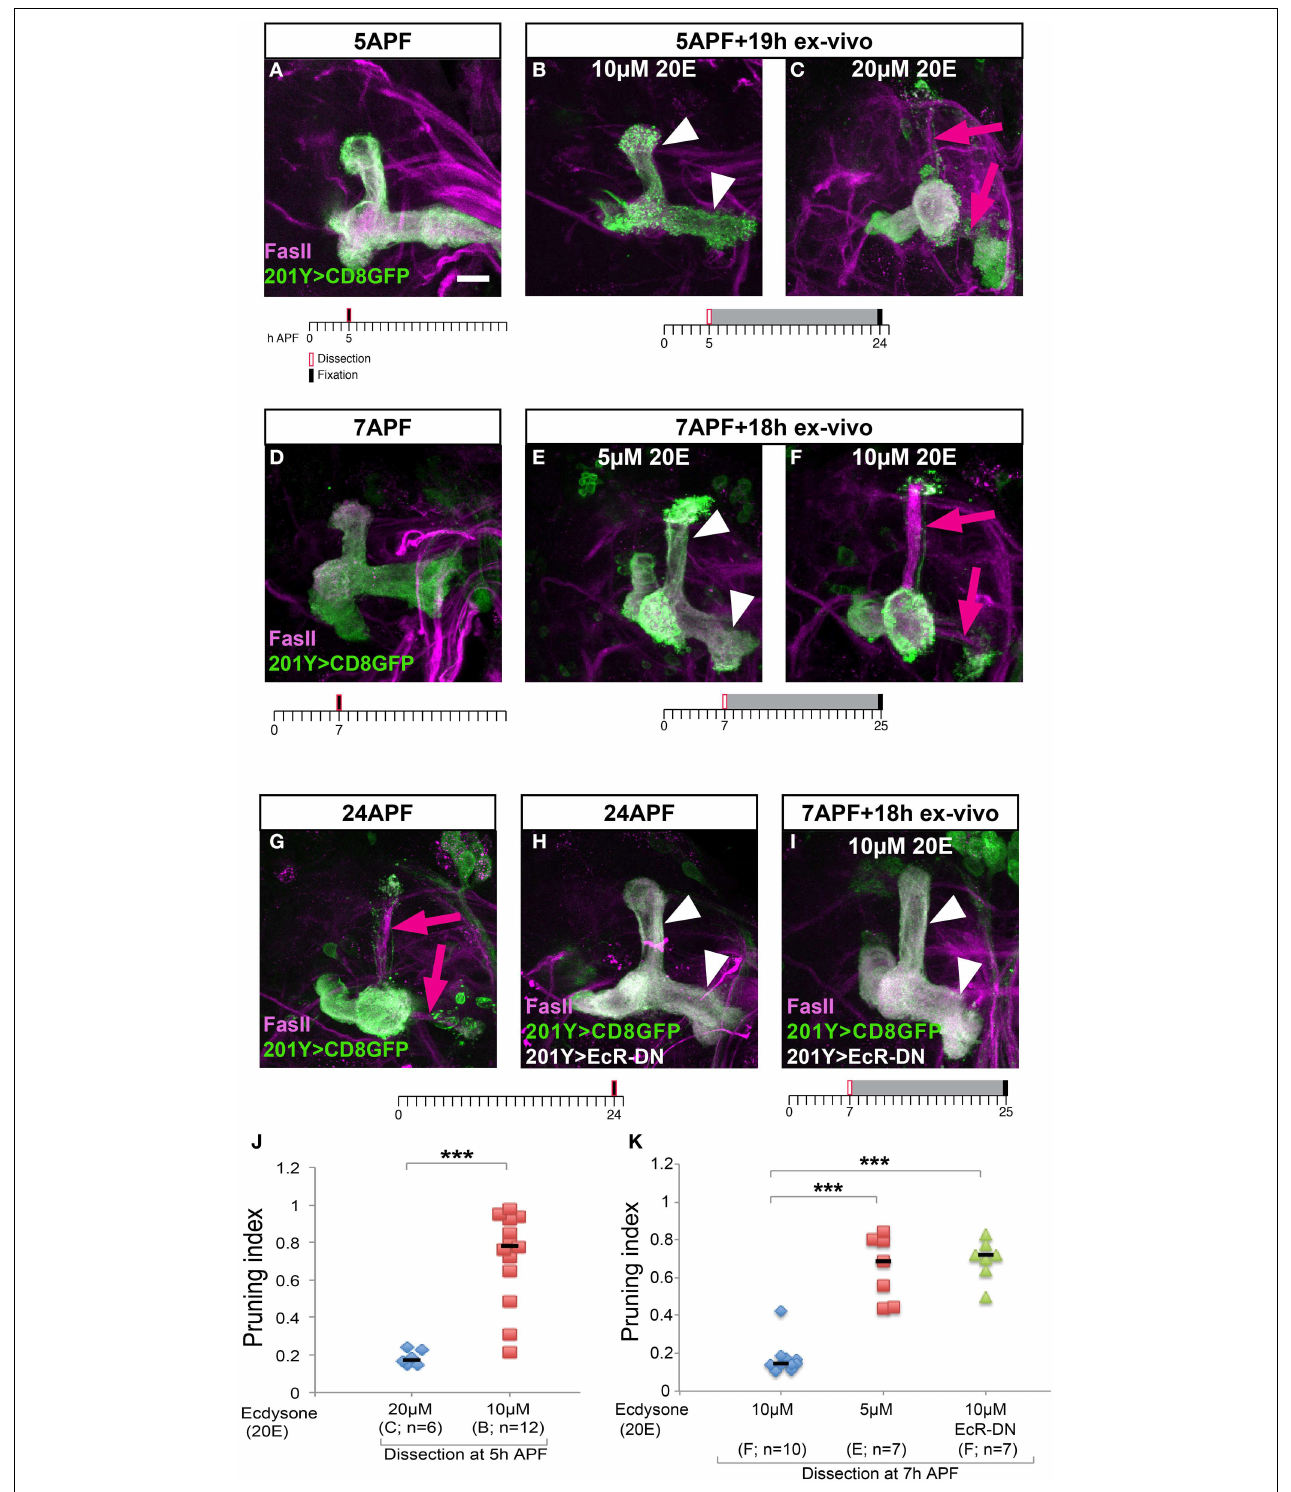
FIGURE 3 | Axon pruning in culture requires differential ecdysone levels, which depends on the age of the pupa. (A–I) Confocal Z-projections of MBs stained for FasII (magenta) and labeled by 201Y-Gal4 driving the expression of membrane bound GFP (mCD8-GFP) in γ neurons.